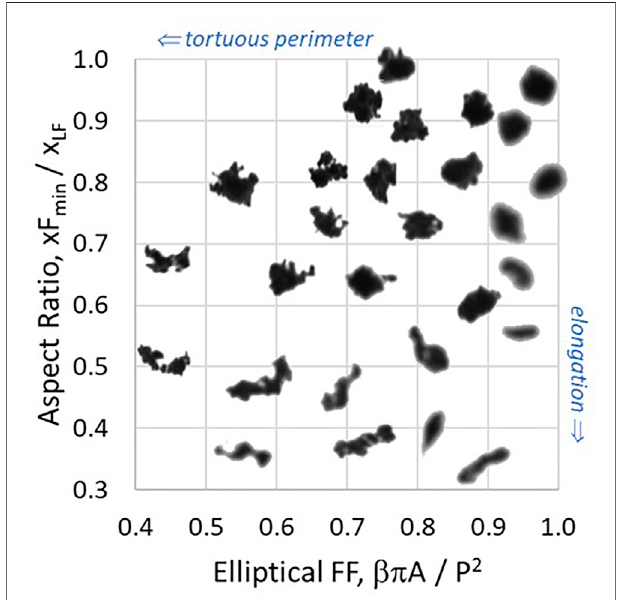
FIGURE 2 | Example particle images placed according to their calculated aspect ratio and elliptical form factor.